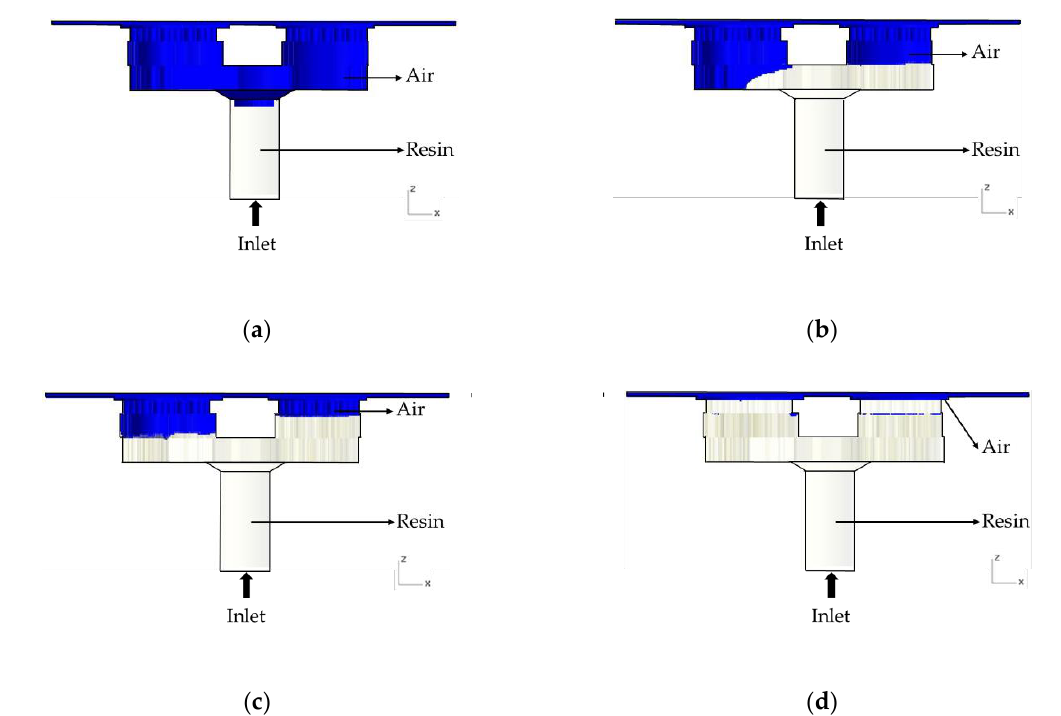
Figure A3. The flow rate is 0.03 cm 3 /s. ( a ) Filling 10%; ( b ) Filling 30%; ( c ) Filling 50%; ( d ) Filling 70%. Figure B3. The flow rate is 0.04 cm 3 /sec. ( a ) Filling 10%; ( b ) Filling 30%; ( c ) Filling 50%; ( d ) Filling 329 70%. 330